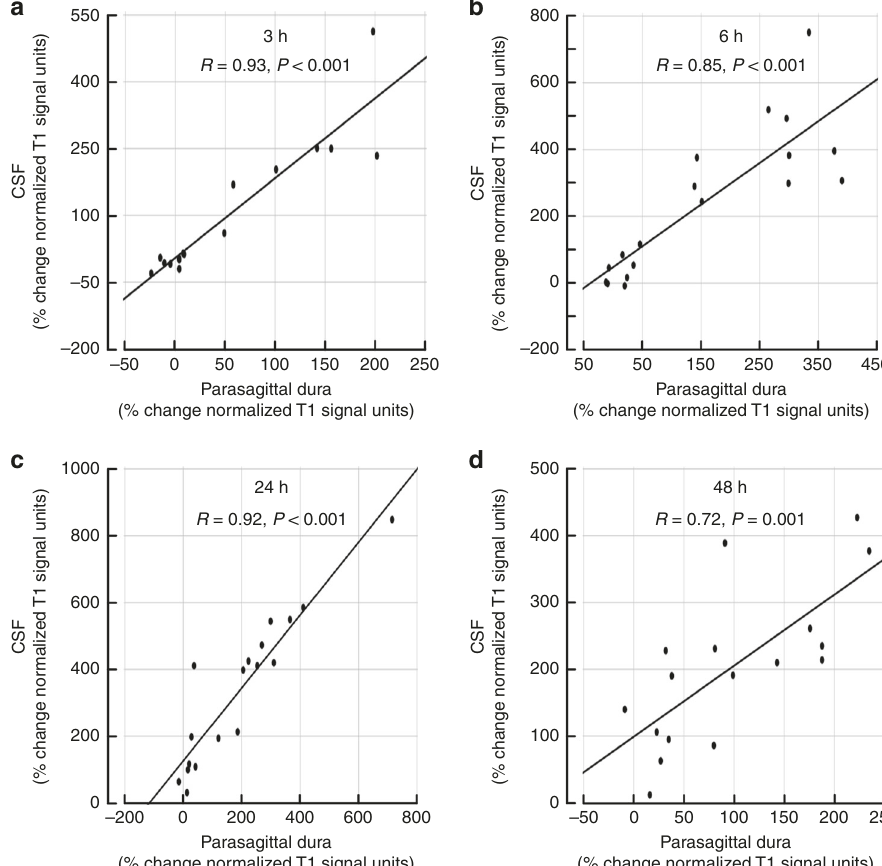
Fig. 4 Correlations between CSF tracer enhancement in parasagittal dura and nearby CSF space. There was a highly signi fi cant positive correlation between CSF tracer enhancement within parasagittal dura and nearby CSF spaces at 3 h ( a ), 6 h ( b ), 24 h ( c ) and 48 h ( d ). Each plot presents the fi t line and the Pearson correlation coef fi cient ( R ) with P